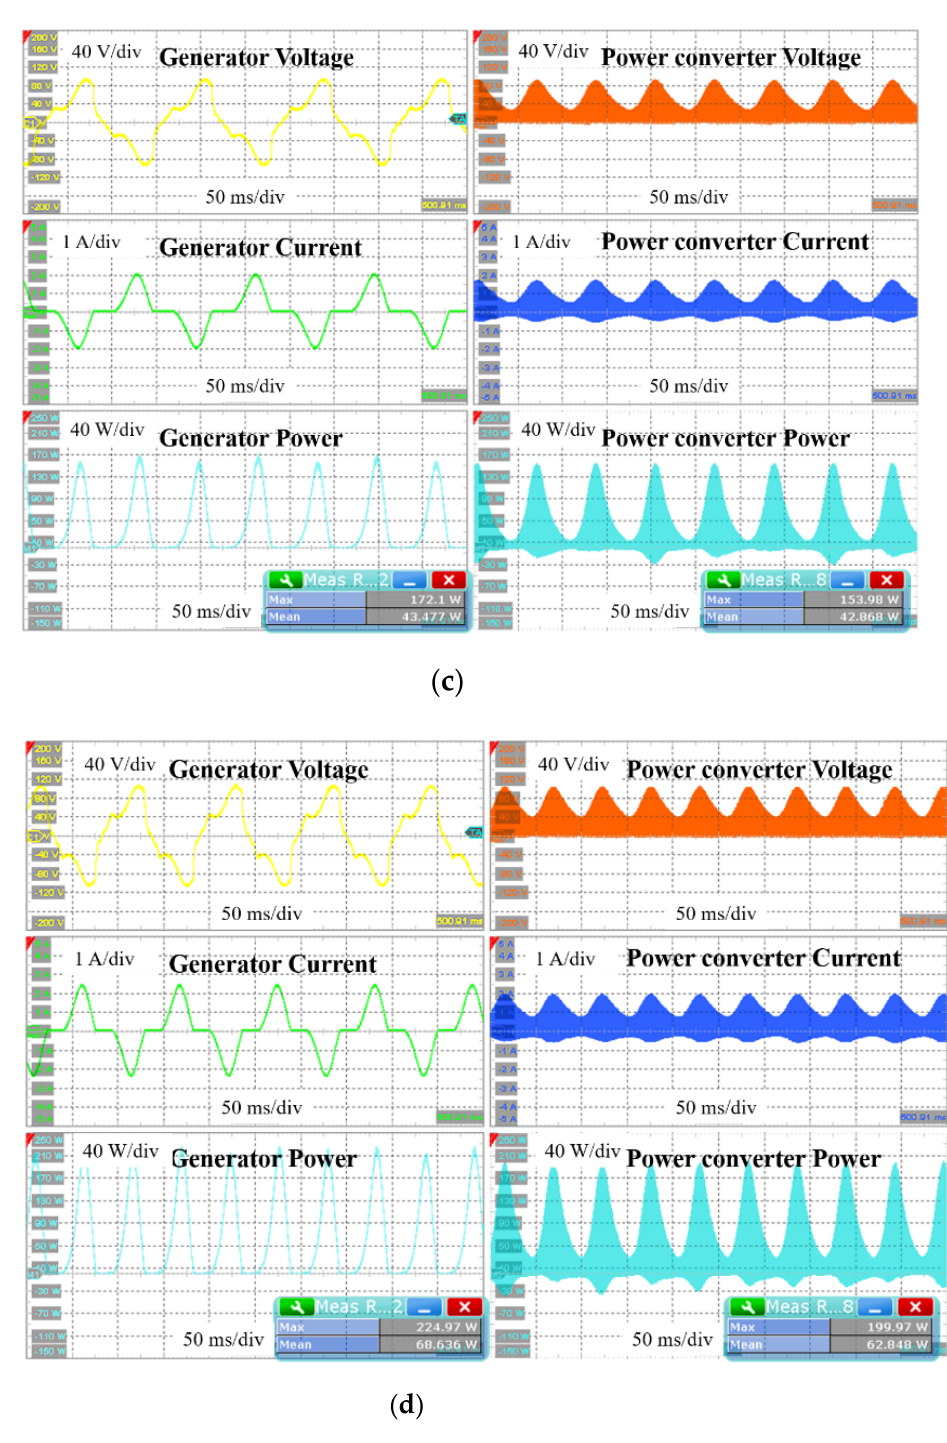
Figure 10. Linear generator and power converter output characteristic waveform by vibration speed: ( a ) 0.1 m/s; ( b ) 0.15 m/s; ( c ) 0.2 m/s; ( d ) 0.25 m/s.